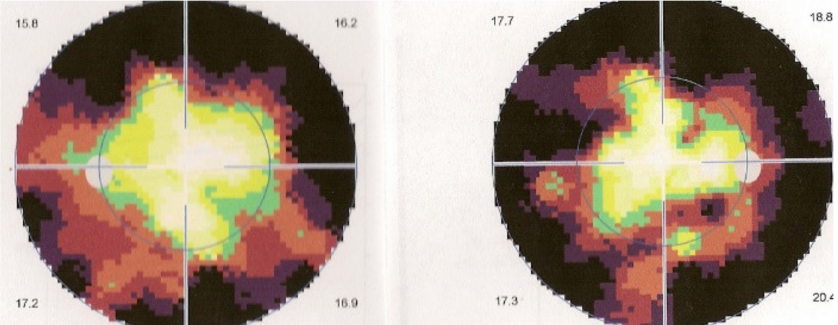
Figure 44. Visual field impairment due to diffuse retinal oedema of posterior pole while fovea is spared. Explains why BRC patients retain a full visual acuity while visual fields are severely impaired.